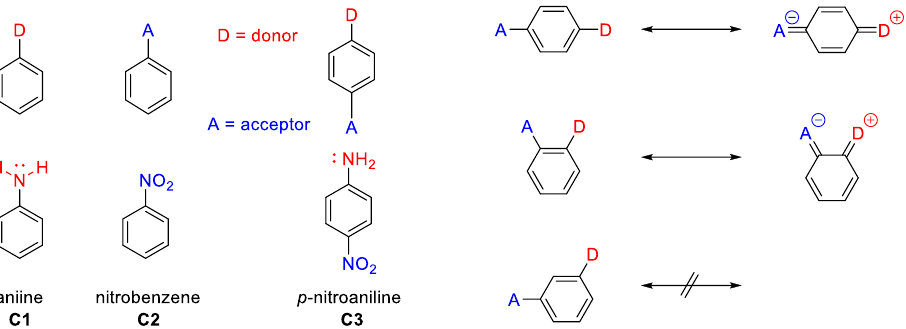
Figure 3. The relative position of the donor–acceptor groups.